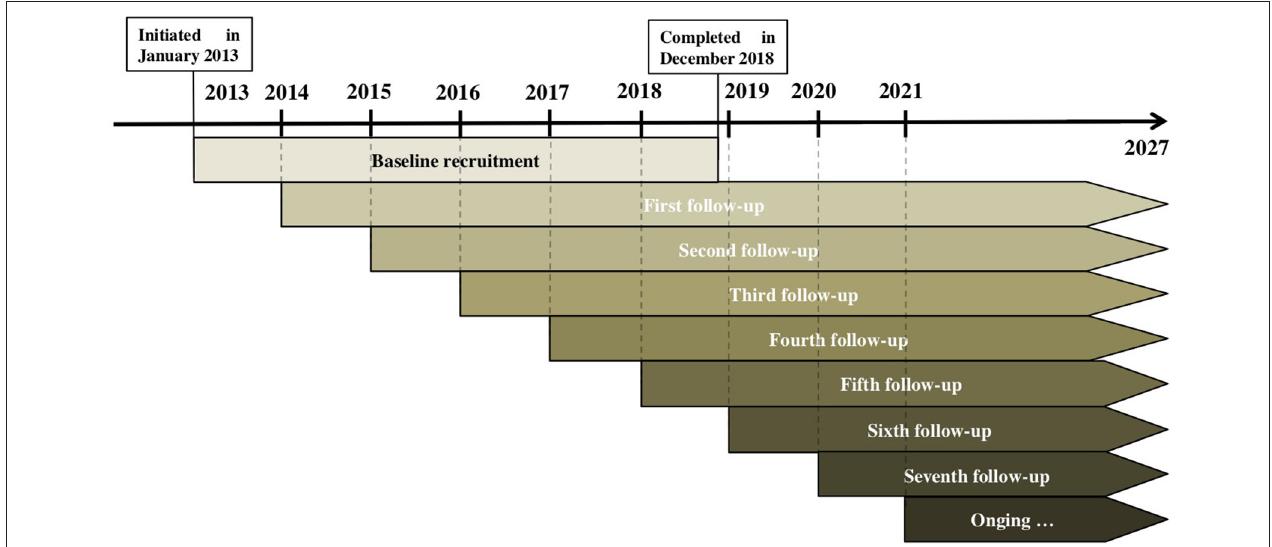
FIGURE 3 | Follow-up periods of the Chinese Adolescent Cohort study. Each participant will be followed up for 8–10 times (from age of 6–8 years to 15 years). Up to now, seven follow-up assessments have been completed for participants recruited in 2013, and the eighth follow-up survey is ongoing in 2021. Follow-ups of children recruited from 2014 to 2018 have been carried out six times, five times, four times, three times and twice, respectively.